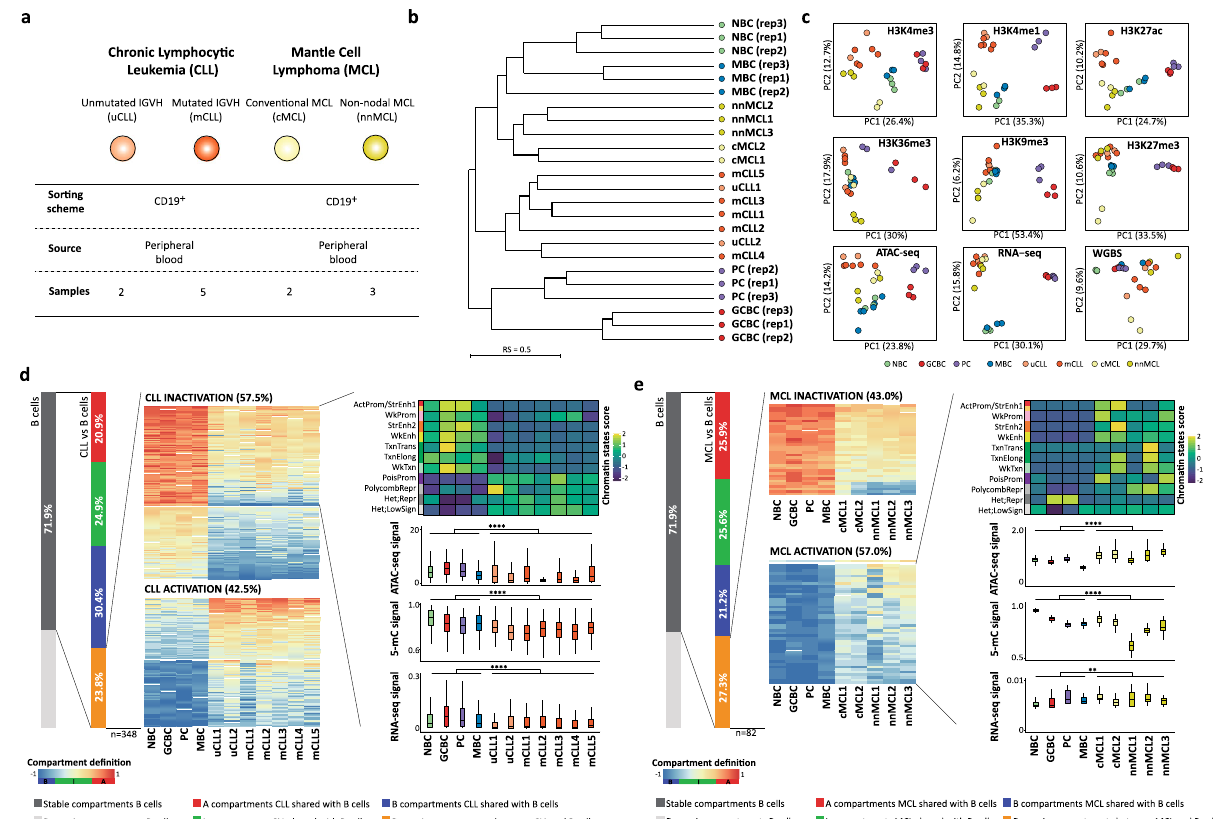
Fig. 4 Characterization of the chromatin architecture of human B cell neoplasms. a Table of samples description together with the number of in situ Hi-C replicates analyzed by each CLL and MCL cases. b Dendrogram of the reproducibility scores for normalized Hi-C contact maps at 100 kb for B cell subpopulations replicates and samples from B cell neoplasia patients. IGHV unmutated (u)CLL; IGHV mutated (m)CLL; conventional (c)MCL and non- nodal (nn)MCL. c Unsupervised principal component analysis (PCA) for nine omics layers generated in the same patient samples as Hi-C: ChIP-seq of six histone marks (H3K4me3 n = 53,241 genomic regions, H3K4me1 n = 54,653 genomic regions, H3K27Ac n = 106,457 genomic regions, H3K36me3 n = 50,530 genomic regions, H3K9me3 n = 137,933 genomic regions, and H3K27me3 n = 117,560 genomic regions), chromatin accessibility measured by